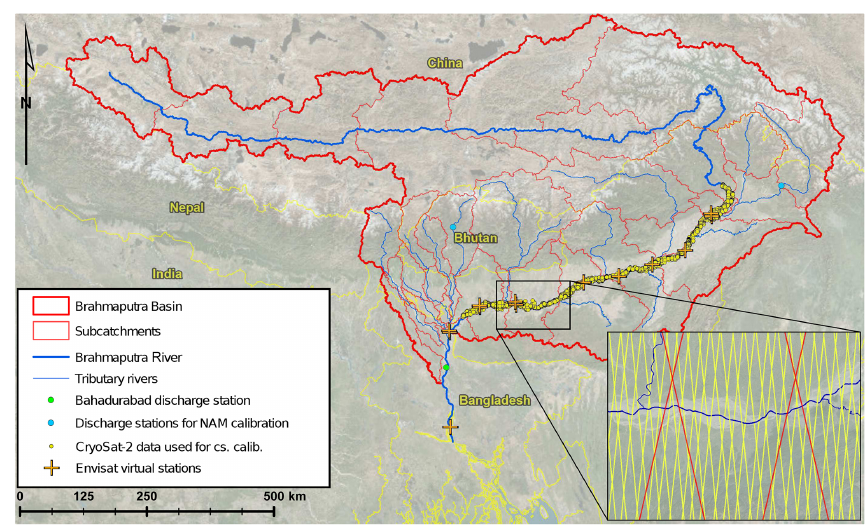
Figure 1. Brahmaputra Basin model base map, showing the altimetry data used for the water-level calibration (the entire upstream part of the Brahmaputra is also covered by the SARIn mode of CryoSat-2). Map inset: ground tracks of CryoSat-2 (yellow) and Envisat (red). The Brahmputra River originates in the Tibetan Plateau, flows eastwards, then bends towards the south to cross the Himalayan Mountains and afterwards flows westwards through the Assam Valley into